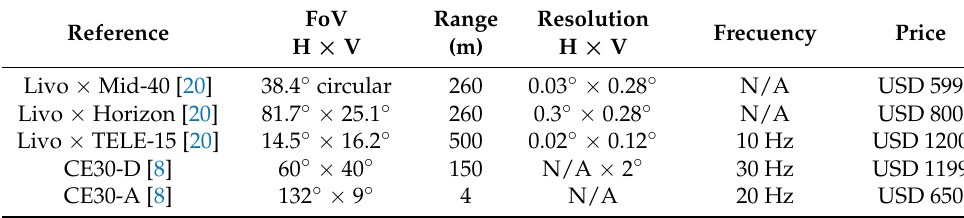
Table 4. Relevant characteristics of solid-state 3D LiDARs used for robot